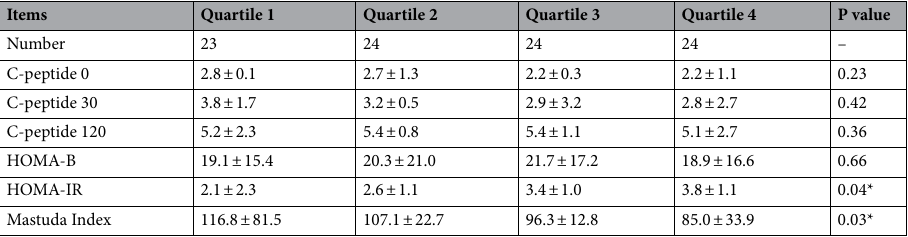
Table 3. The β-cell function and insulin sensitivity in recruited subjects across 4 quartiles of ErbB2 concentrations. Data were presented as means ± SD, *P < 0.05. C-peptide 0 C-peptide 0 min (ng/mL),